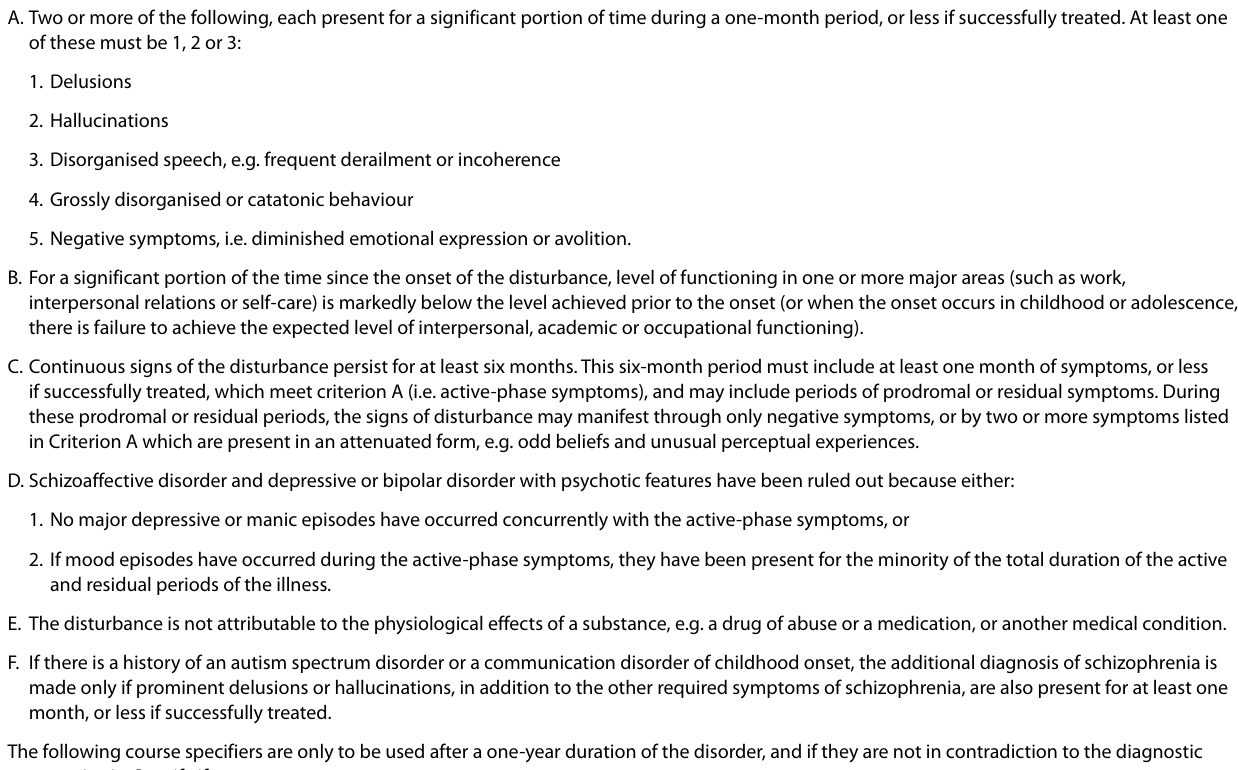
Table 2: Diagnostic criteria for schizophrenia, according to The Diagnostic and Statistical Manual of Mental Disorders, Fifth Edition A. Two or more of the following, each present for a significant portion of time during a one-month period, or less if successfully treated. At least one of these must be 1, 2 or